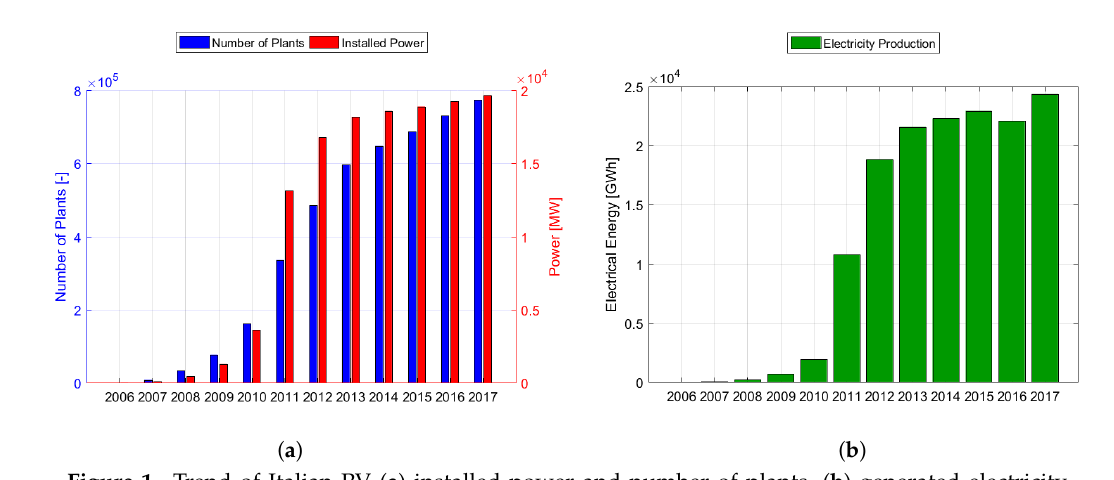
Figure 1. Trend of Italian PV ( a ) installed power and number of plants, ( b ) generated electricity. Source: